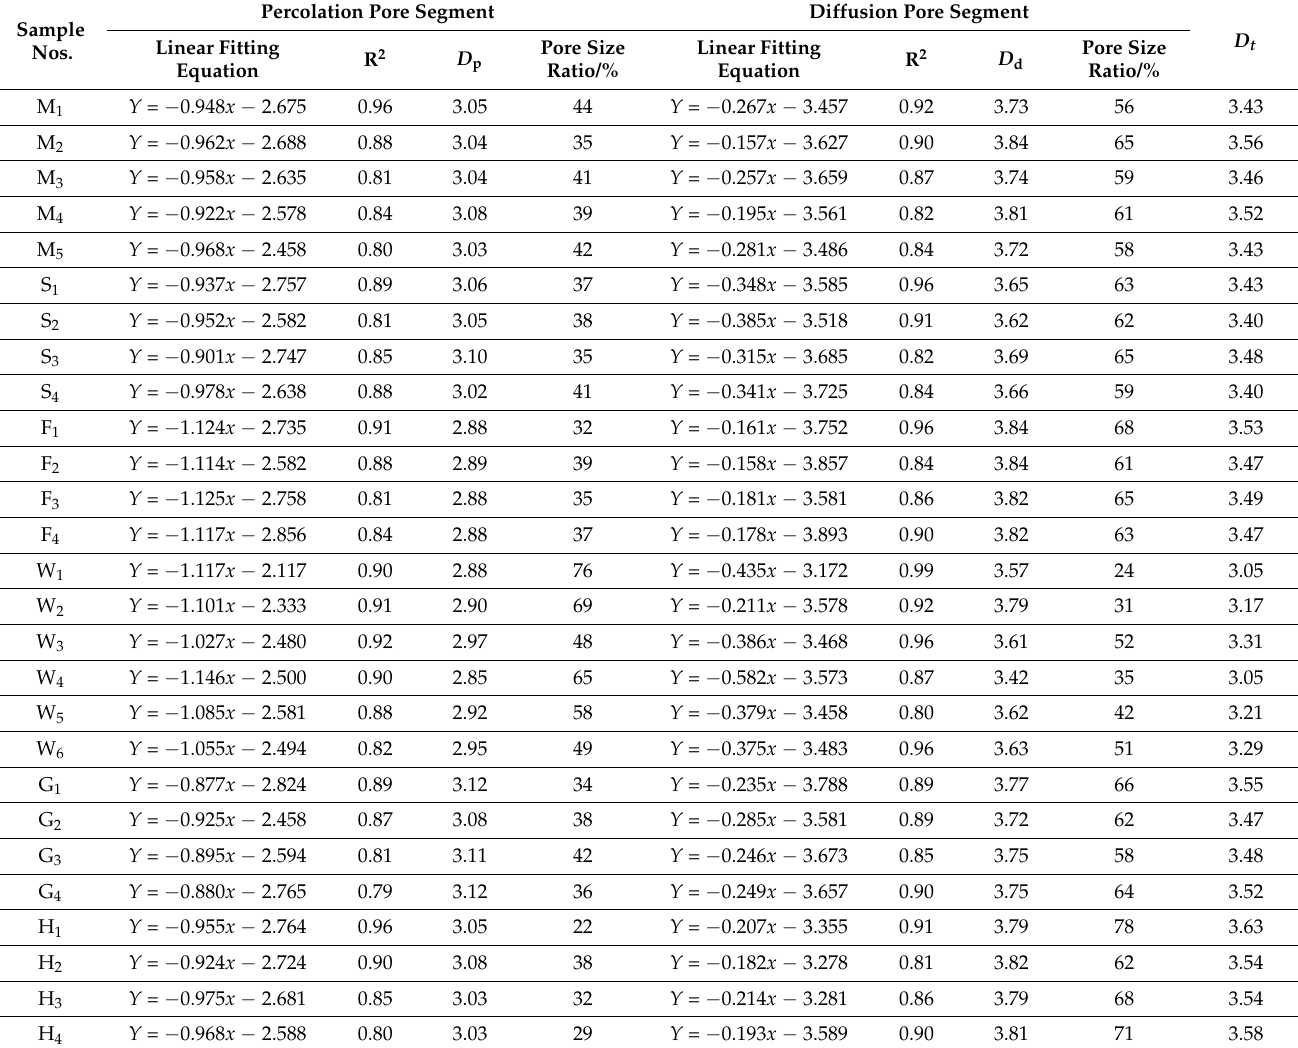
Table 2 lists the fractal dimension, correlation coefficient, and pore size ratio of some coal samples with different pore sizes. According to Equation (2), the comprehensive fractal dimension ( D t ) of each coal sample is obtained as a weighted average. Table 2. Calculation results of fractal dimension of some coal